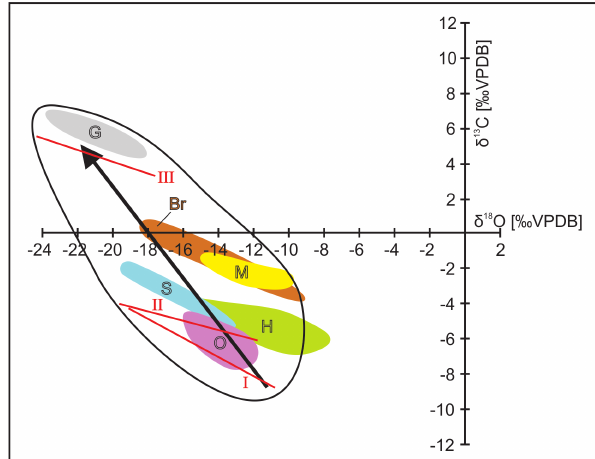
Fig. 10. Carbon and oxygen isotopic composition of cryogenic cave calcites from various cave localities in Central Europe: I– III: regression lines according to ˇZ´ak et al. (2004): I Jaskinia Jaworznicka Cave system, II BUML Cave, III Stratensk´a Jaskya Cave. The different data fields are based on the interpretation by the Bochum group. O = Ostenberg Cave - Richter and Nigge- mann (2005); S = Sunderner Cave - Richter et al. (2009a); H = Heilenbecke Cave - Richter et al. (2008); M = Malachitdom – Richter and Riechelmann (2008); Br = Herbstlabyrinth-Advent Cave system – this work, G = Glaseis Cave – Richter et al.